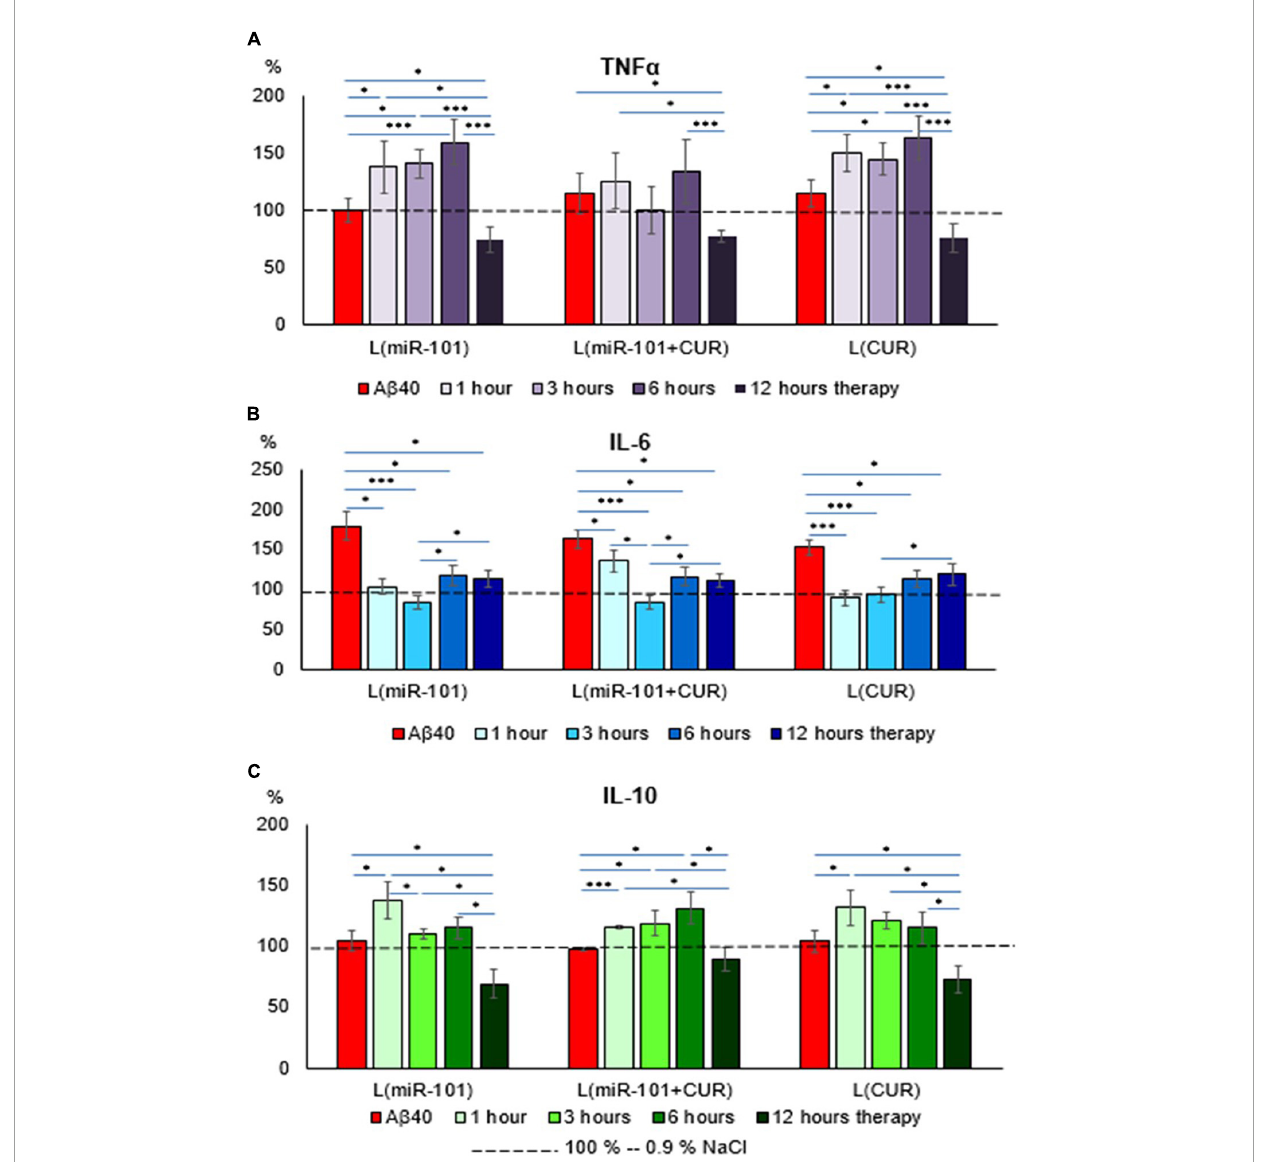
FIGURE2 Diagrams of the relative content of cytokines: TNF α (A) , IL-6 (B) , and IL-10 (C) in mononuclear cell suspension after 1 h of incubation with A β 40 aggregates and subsequent incubation over time 1, 3, 6, and 12 h with liposomal forms of miR-101, CUR, and miR-101 + CUR. The vertical axis is the concentration of the corresponding cytokine in the target samples normalized to the corresponding concentration of this substance in the suspension of mononuclear cells incubated with saline, %. * P < 0.05, *** P <